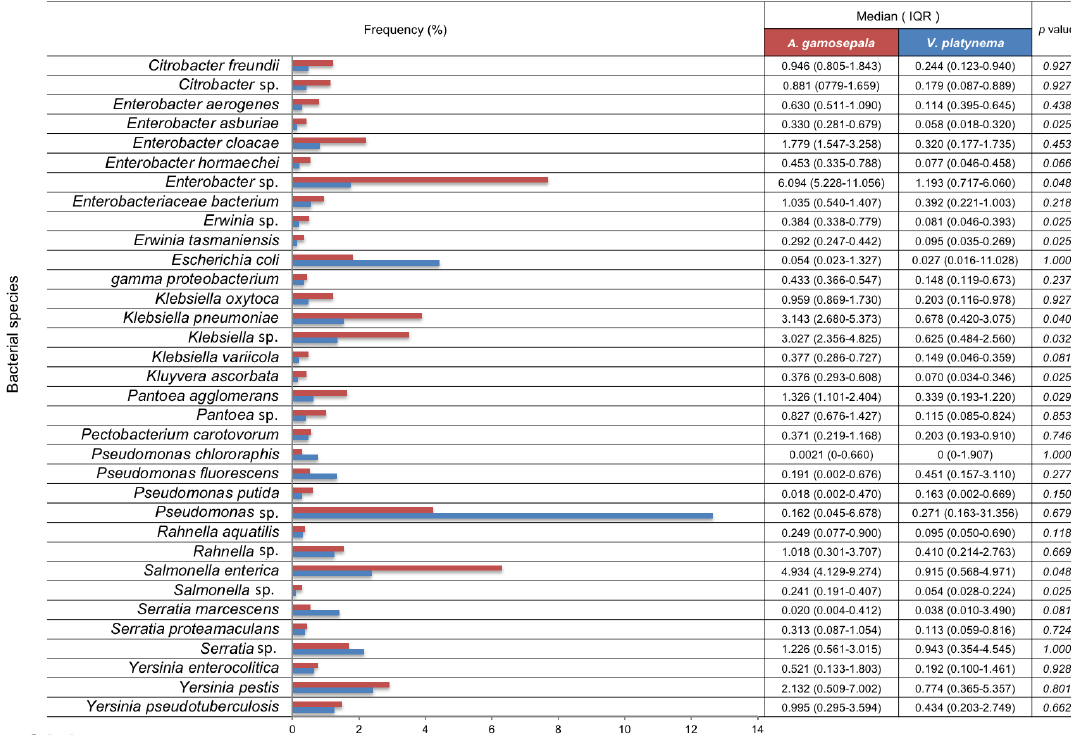
Table 4. Average of relative abundances of the most frequent bacterial species observed in A. gamosepala and V. platynema . A total of 1,110,704 16S rRNA sequences were analyzed.